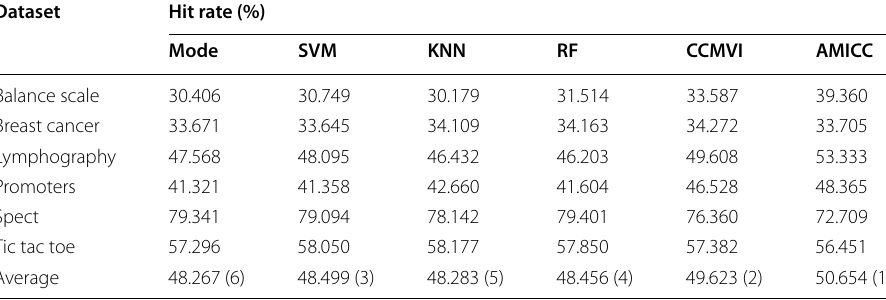
Table 12 Average hit rates of the MVI methods for the categorical datasets Dataset